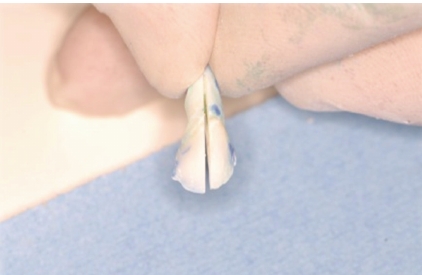
Figure 3: Tooth cut in 2 parts in the vestibule-lingual direction in order to obtain 2 symmetrical fragments. Table 1: Criteria used by the two blind operators to assign the scores for infiltration evaluation.